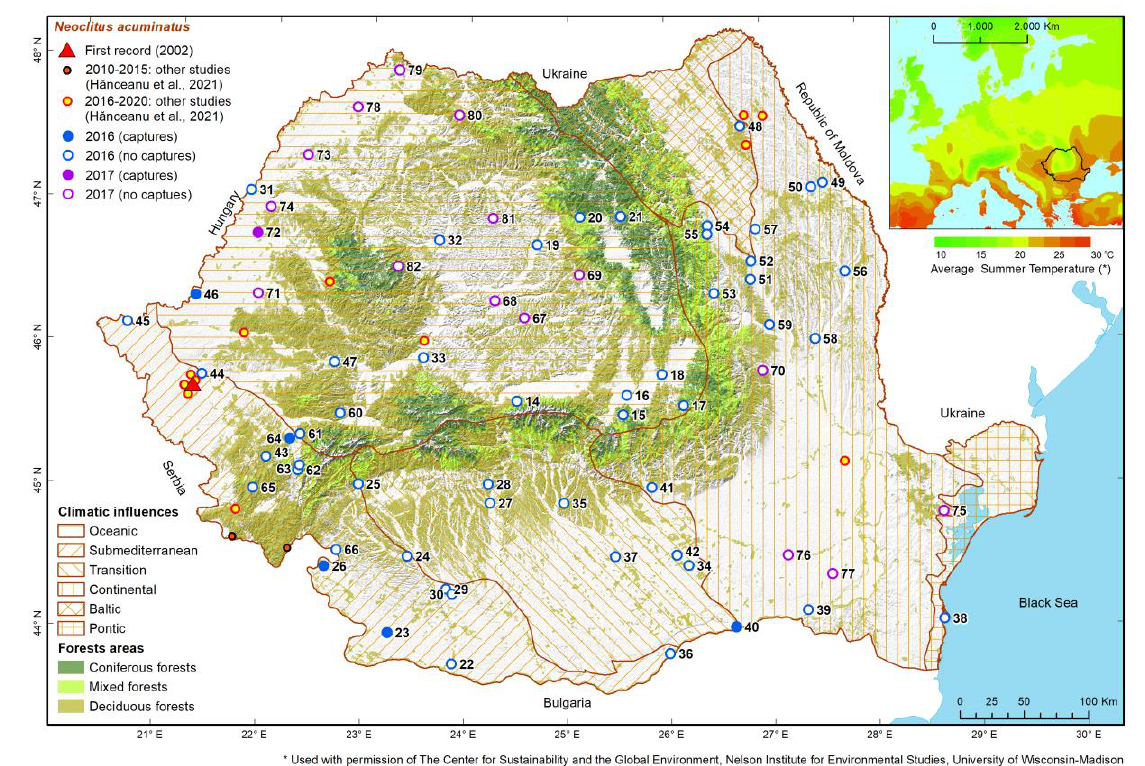
Figure 10. Geographic distribution of places where RHAB presence was detected between 2002 and 2020, based on data from own and other studies [128]. (The correspondences between point numbers in our study and names of locations are given in Table